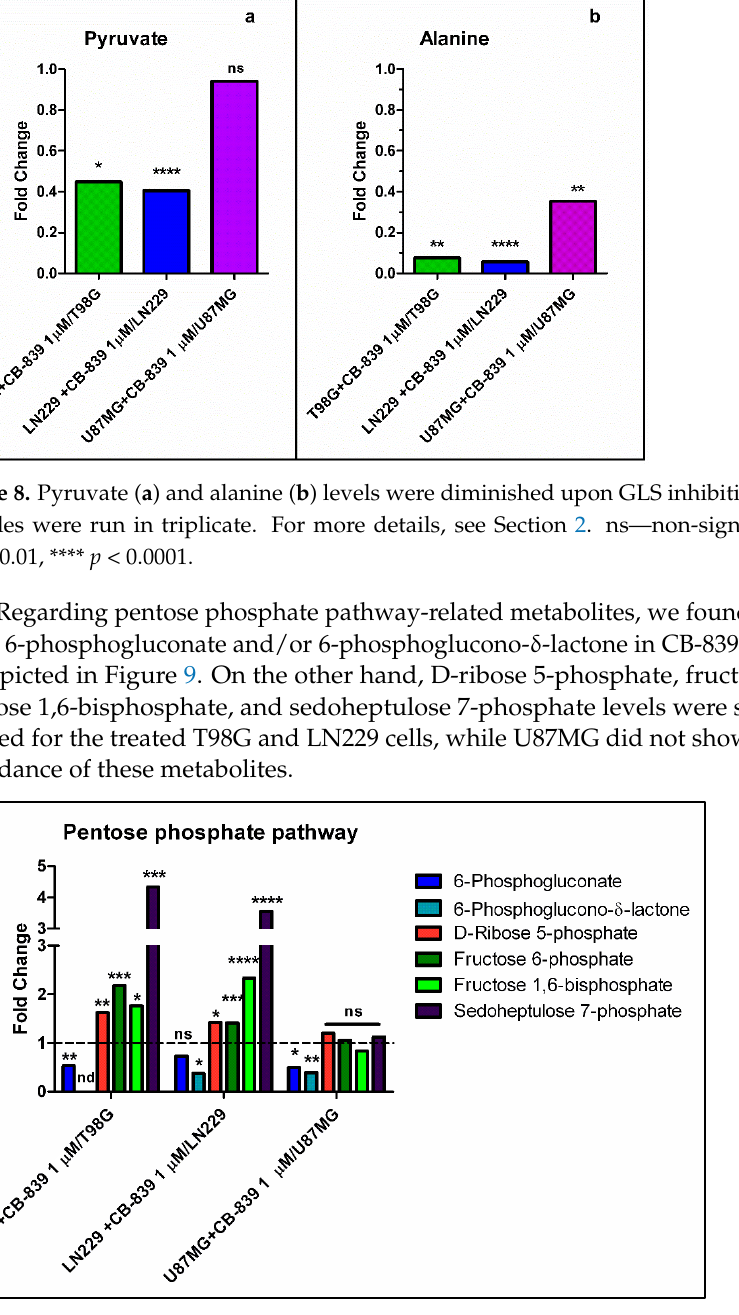
Figure 7. TCAC metabolites altered by specific GLS inhibitor CB-839. Results are depicted for T98G ( a ), LN229 ( b ), and U87MG ( c ). The samples were run in triplicate. For more details, see Section 2. * p < 0.05, ** p < 0.01, *** p < 0.001, **** p < 0.0001. Moreover, pyruvate and alanine levels were also depleted upon CB-839 treatment, as shown in Figure 8. Pyruvate levels were significantly diminished in treated T98G and LN229 cells (0.4 to 0.45-fold), while it did not significantly change for the treated U87MG cells; alanine levels were significantly diminished in the three treated cell lines (from 0.05 to 0.35-fold).